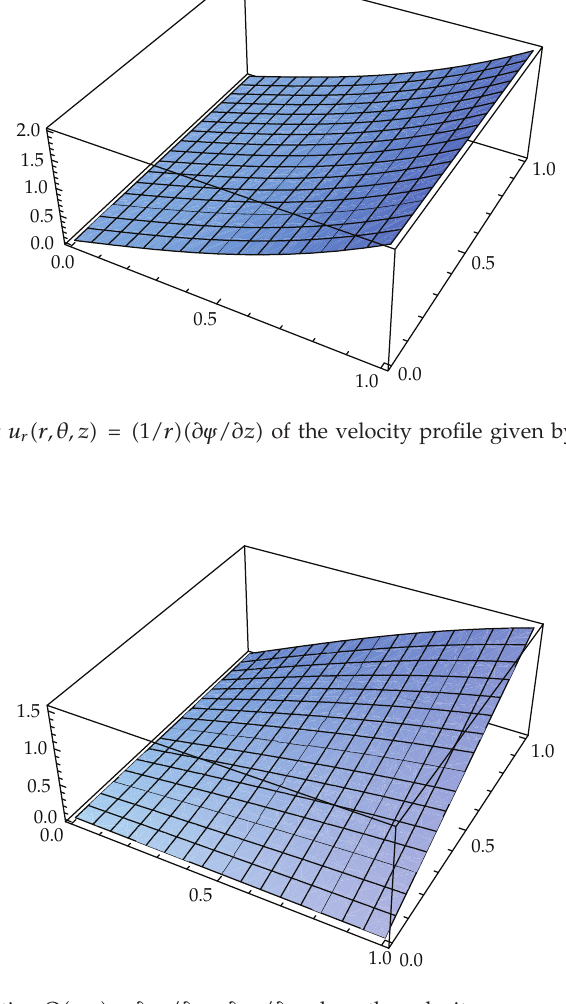
Figure 4: Vorticity function Ω(cid:3) r,z (cid:4) (cid:5) ∂u r /∂z − ∂u z /∂r where the velocity components have been obtained by OHAM, for R (cid:5) 1, γ (cid:5)